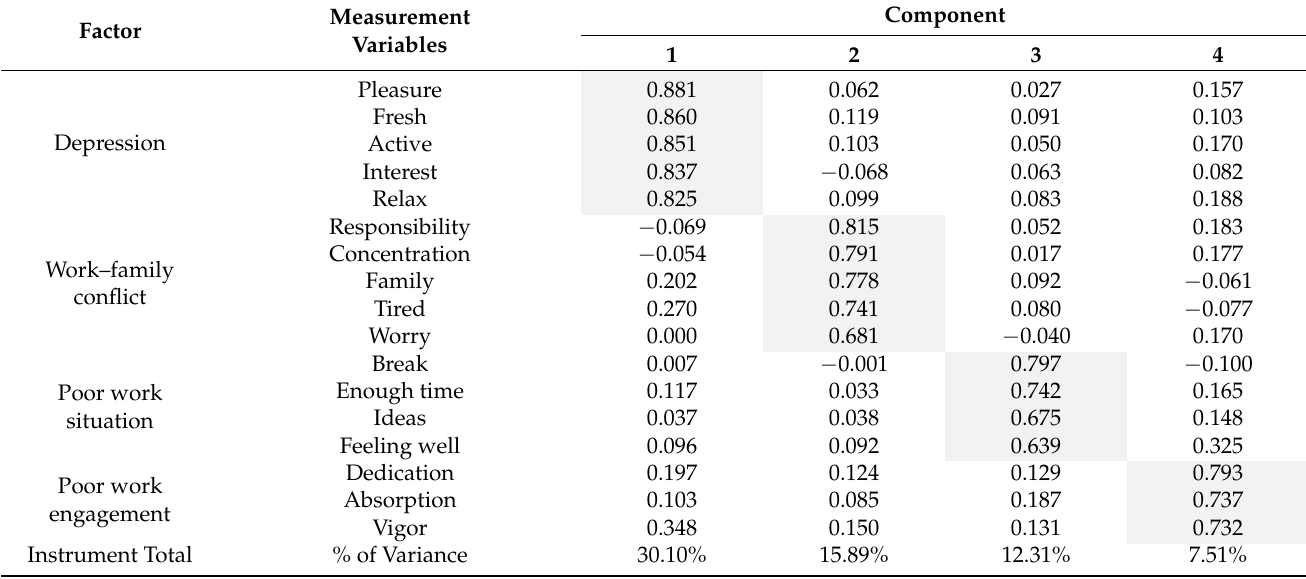
Table 4. Results of factor analysis.